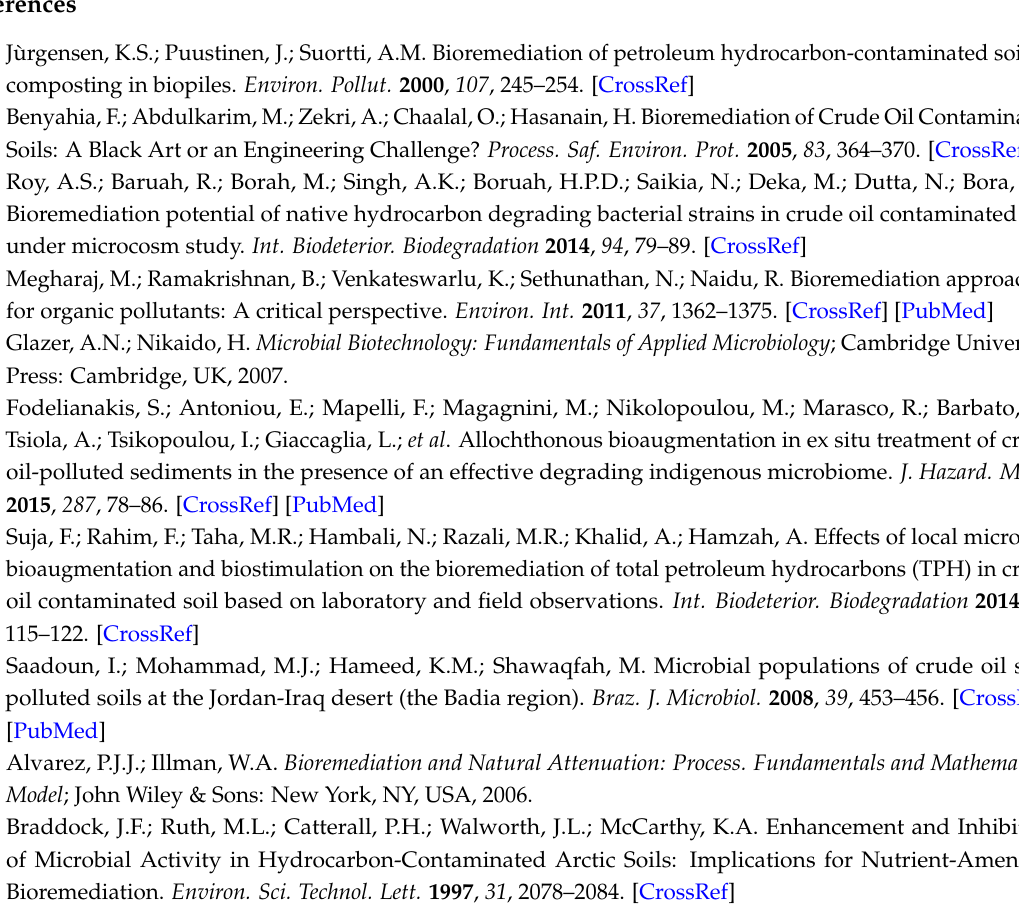
Figure A2. Biopile systems used in this work.